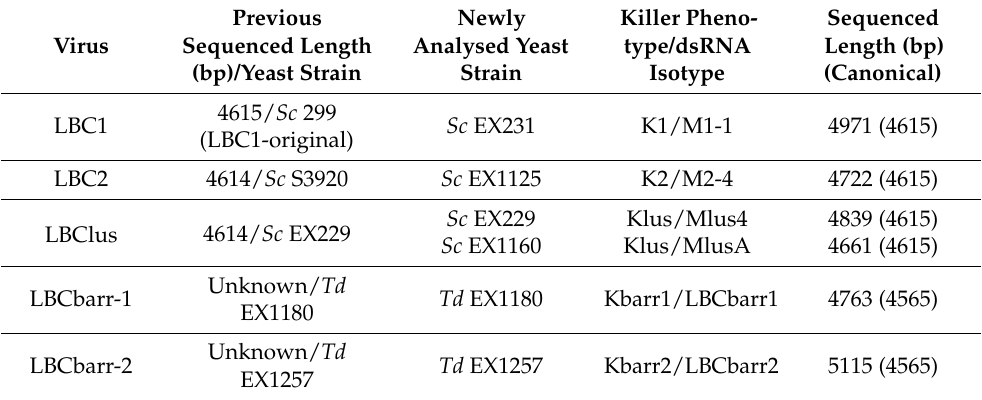
Table 1. Characteristics of the dsRNA LBC-virus genomes sequenced by